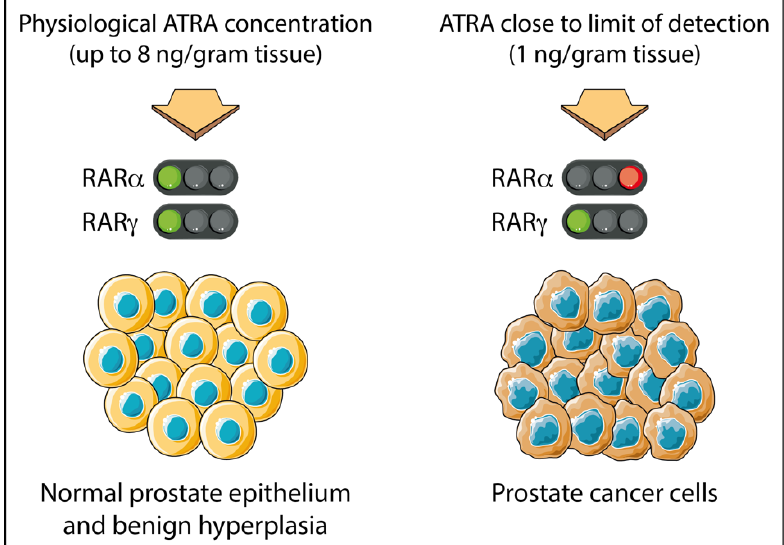
Figure 1. Prostate cancer tissue is adapted to grow in sub-nanomolar concentrations of ATRA. Adjacent normal cells and benign prostate hyperplasia cells see ~8 times more ATRA than level within patients’ PCa tissue which is close to the level of detection at ~1 ng/g tissue [28]. For patients’ PCa tissue, there is sufficient to transactivate RAR γ , which requires just 0.24 nM ATRA (see Table 2). RAR α requires 19.3 nM ATRA for transactivation (see Table 2) and therefore is unlikely to be active within patients’ PCa tissue. This figure was created using Servier Medical Art templates, which